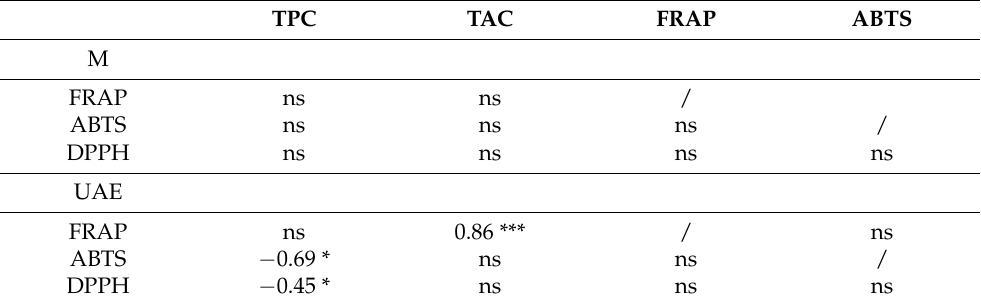
Table 2. Correlation analysis between total phenolic content (TPC), total anthocyanin content (TAC), and antioxidant activity measured with the assays FRAP, ABTS, and DPPH, as regards maceration (M) and UAE. Pearson or Kendall correlation coefficients are reported for p -values <